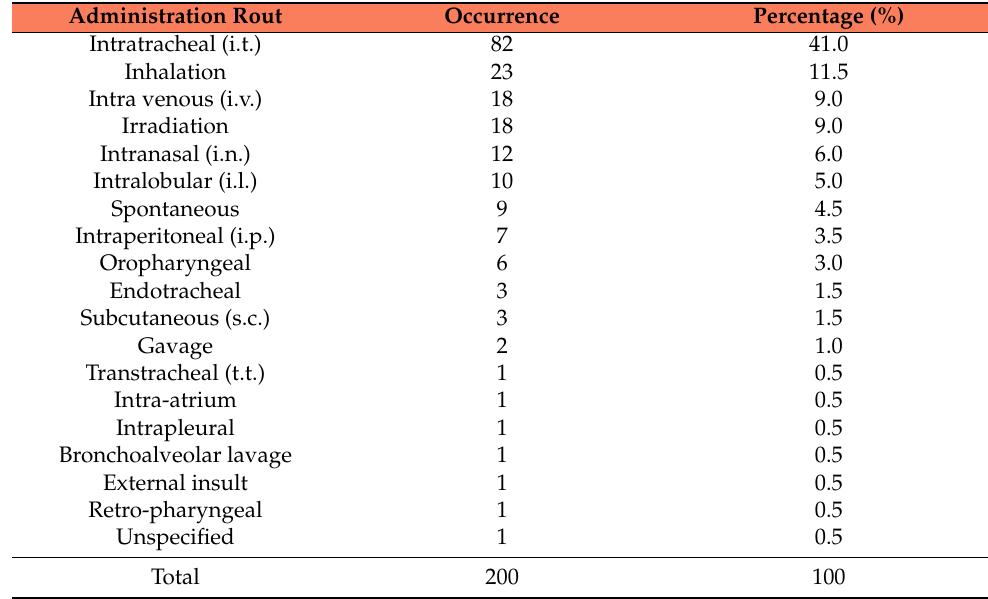
Table 3. Administration route of lung injury substance or source of injury-inducing